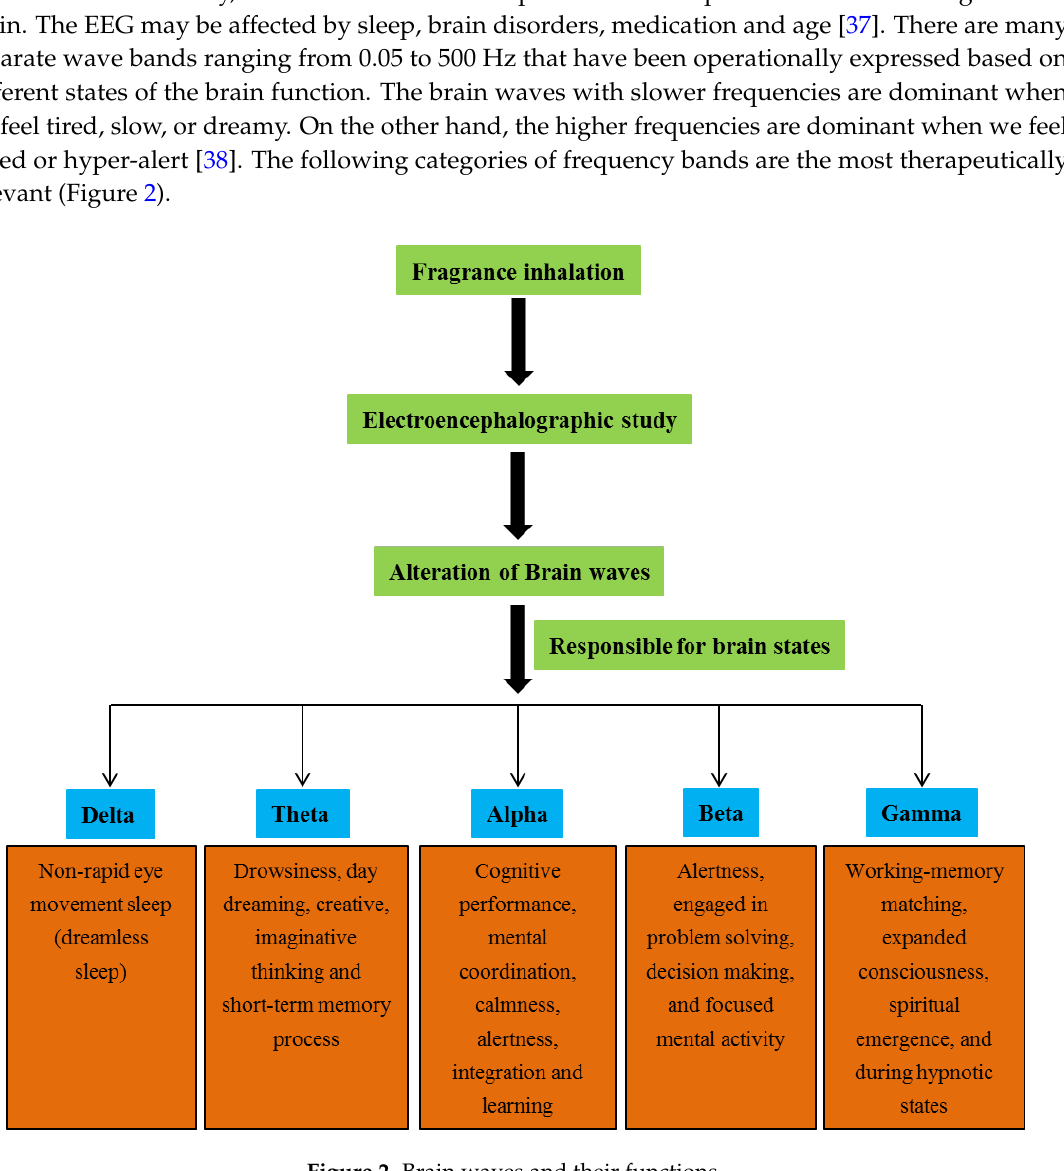
Figure 2. Brain waves and their functions.